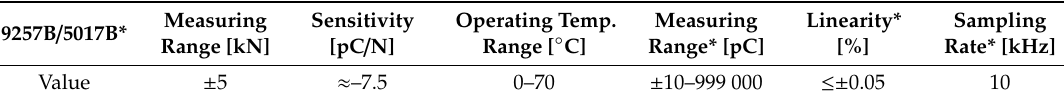
Table 2. Basic specifications of Kistler 9257B and amplifier 5017B [55]